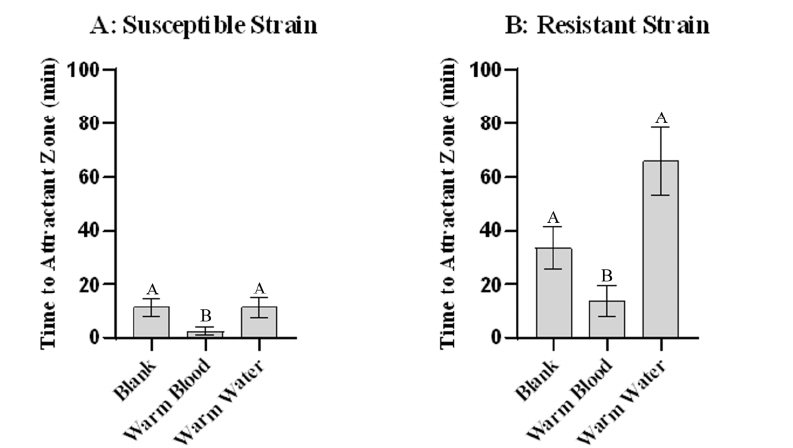
Figure 5. Repellent activity in presence of food source, baseline results. The amount of time (mean +/ − SEM) it took for subjects in susceptible strain ( A ) and resistant strain ( B ) to enter the attractant zone, in minutes, when zone contained warmed blood, warmed water, or neither (blank). Different letters above them are significantly different at α = 0.05. A: ANOVA: n = 20 per treatment ( n = 60 total), F(2, 57) = 6.573, p = 0.0027. Holm-Šidák’s multiple comparisons: Warm blood vs. blank, p = 0.0025; warm blood vs. warm water, p = 0.0322; blank vs. warm water, p = 0.2959. B: ANOVA: n = 20 per treatment ( n = 60 total), F(2, 57) = 4.613, p = 0.0139. Holm-Šid á k’s multiple comparisons: Warm blood vs. blank, p = 0.0451; warm blood vs. warm water, p = 0.0182; blank vs. warm water, p = 0.6135.